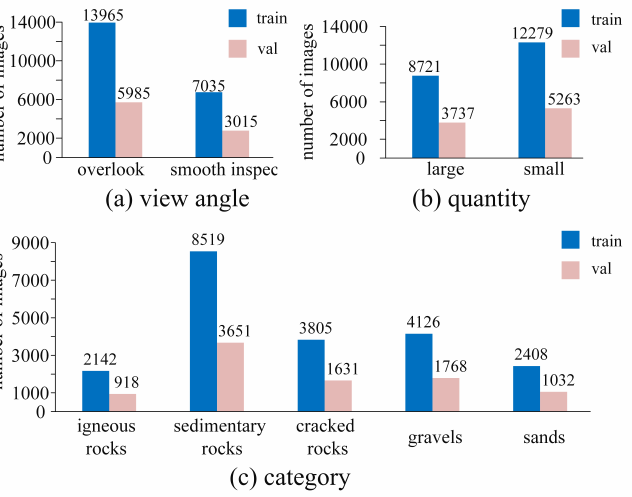
Figure 2. The marginal distributions of the number of images in the current GMSRI. ( a ) Number of images in each view angle. ( b ) Number of images in each quantity. ( c ) Number of images in each